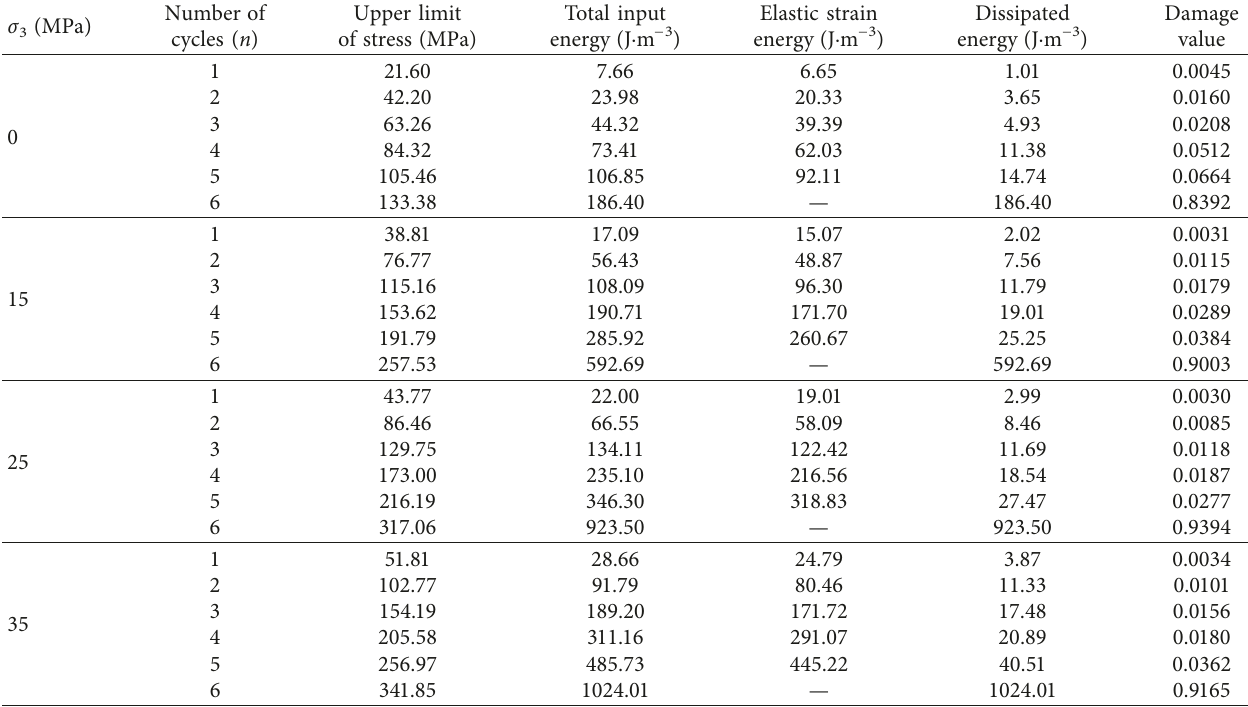
Table 1: Energy and damage for the samples under different confining